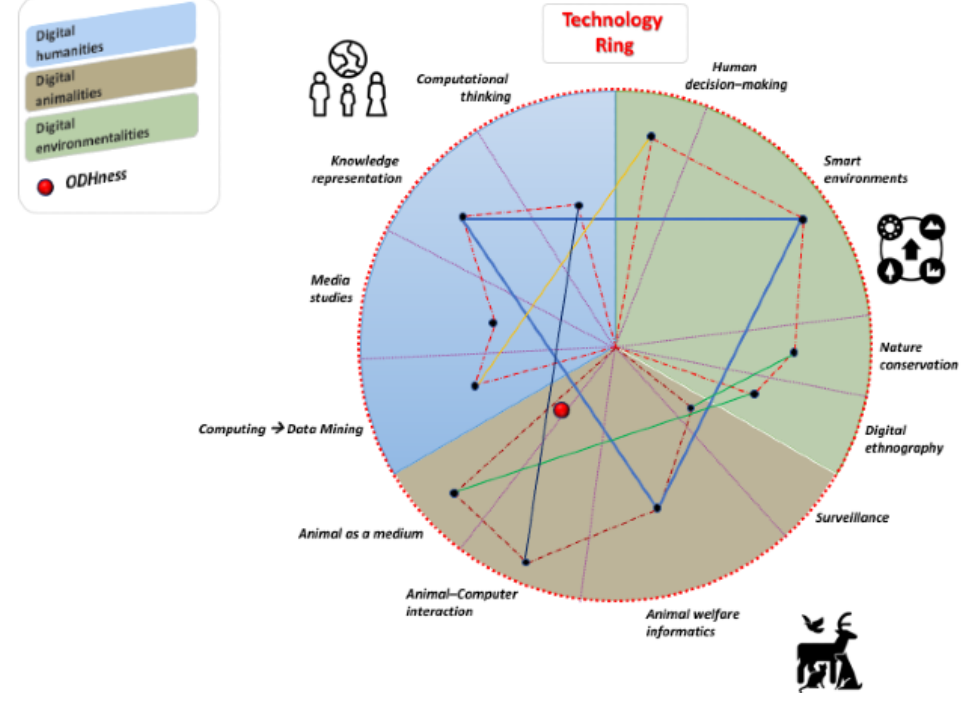
Figure 3. Pandemic-related "ODHness" interactions within the technology